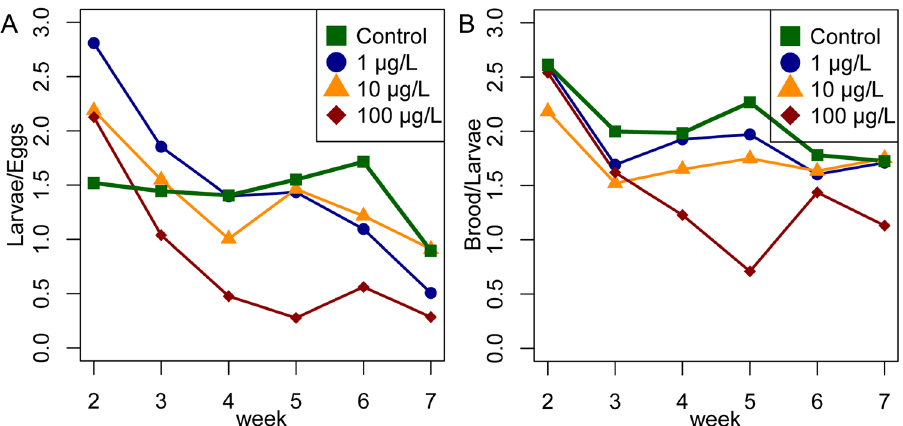
Figure 5. Ratio between developmental stages. ( A ) The ratio of the number of larvae/eggs. The eggs in week 2 become the larvae of week 3, so the number of larvae is shifted by 1 week. The ratio of controls is stable throughout the experiment (mean = 1.5) until week 7, where a seasonally related drop in brood activity was observed. ( B ) The ratio of capped brood/larvae (number of capped brood shifted by 1 week) was stable in the controls (mean = 2.06), and the 1 µg/L (mean = 1.92) and 10 µg/L (mean = 1.7) groups, but dropped in the 100 µ/L treatment group in weeks 4 and 6 (mean =